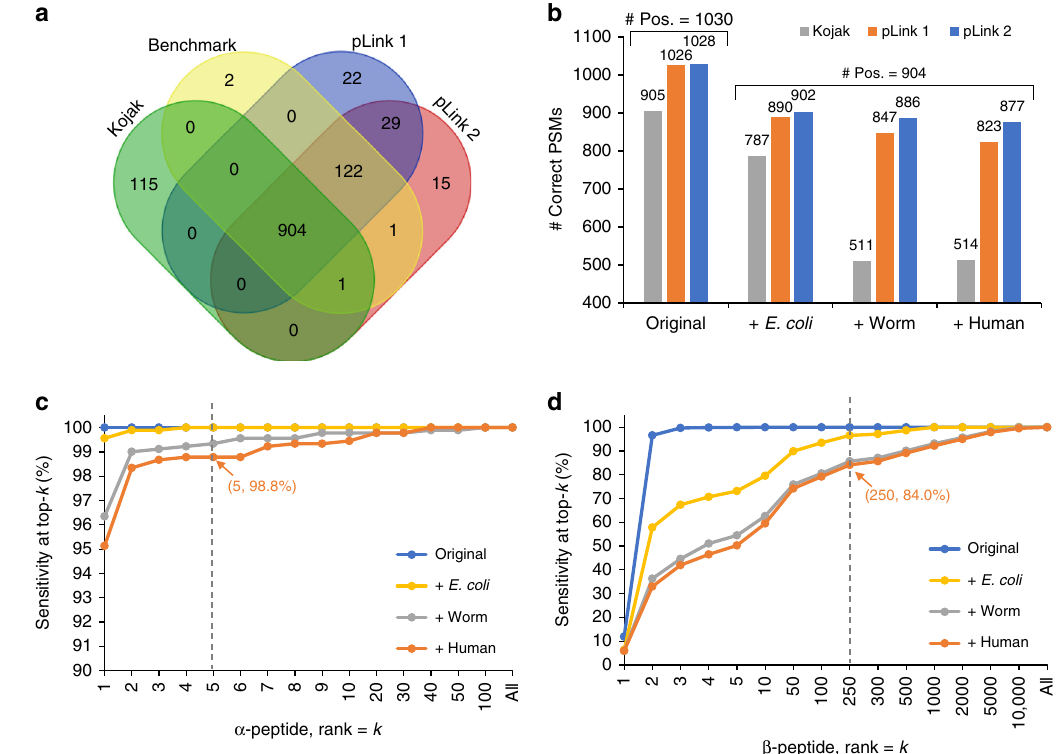
Fig. 2 Performance evaluation on the Synthetic-BS3 dataset. a Venn diagram for the results of Kojak, pLink 1, pLink 2, and the benchmark. A total of 904 PSMs were correctly identi fi ed consistently by the three engines; these were used to be a new and fair standard dataset. b The numbers of correctly identi fi ed PSMs by each search engine. c The percentage of correct α -peptides ranking in the top- k in the open search stage of pLink 2. d Similar to c , but for β -peptides. The “ Original ” database contains only the sequences of 38 synthetic peptides, “ + E. coli ” database contains sequences from the “ Original ” database and the E. coli whole proteome database, and “ + Worm ” and “ + Human ” are similar to “ + E. coli